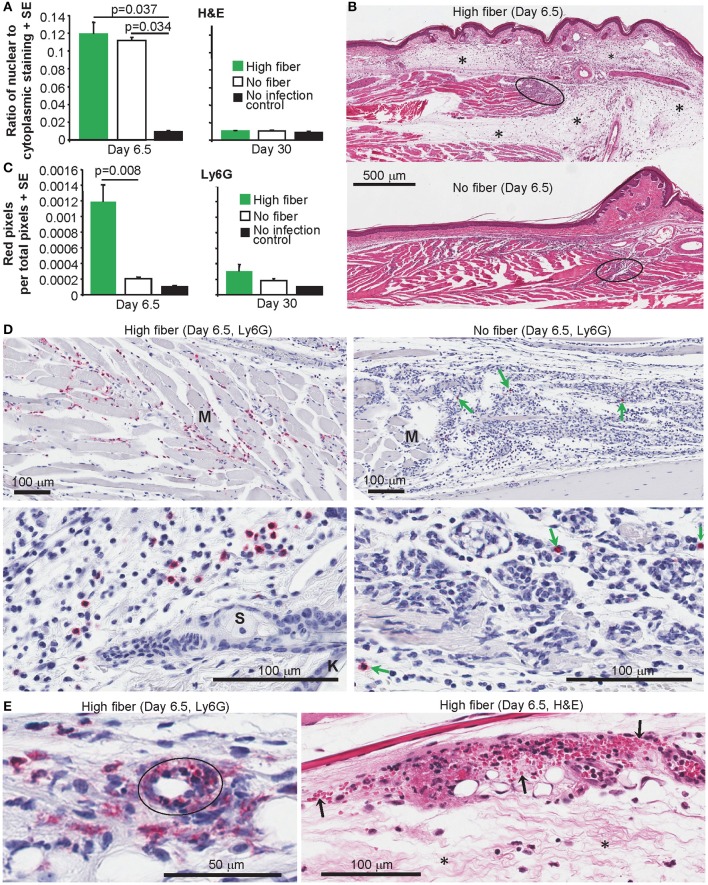
Histology and IHC of feet from CHIKV-infected mice fed high and no fiber diets. (A) Mice were fed with high fiber or no fiber diet and infected with CHIKV or left uninfected (No infection control) (as in Figure 1A). On day 6.5 and day 30 feet from separated groups of mice were examined by histology and H&E staining. Aperio pixel count was used to determine the ratio of strong blue (nuclear) to red (cytoplasmic) staining; a measure of the cellular infiltrate. Statistics by Kolmogorov Smirnov test (p = 0.037, n = 4 feet and mice per group) and Kruskal–Wallis test (p = 0.034, n = 3/4 feet and mice per group). There were no significant differences between any groups on day 30 post infection (n = 4 feet and mice per group). (B) Examples of H&E staining of mice examined in (A). Black ovals indicate areas of high density infiltrates in muscle tissues. Asterisks (*) indicate areas of edema. (C) Feet from groups of mice as in (A) were analyzed by IHC and the neutrophil-specific anti-Ly6G antibody. Anti-Ly6G staining was detected using Warp Red, with red staining quantified by Aperio pixel count. Statistics by Kolmogorov Smirnov test (Day 6.5, p = 0.008, n = 4–9 feet and mice per group). There were no significant differences between any groups on day 30 post infection (n = 5/6 feet and mice per group). (D) Examples of anti-Ly6G IHC (Red) in muscle (top panels) and subcutaneous tissues (bottom panels). M, a muscle bundle; K, keratinocyte epidermal skin layer; S, Sebaceous gland. (E) Anti-Ly6G IHC (Red) showing a blood vessel (black oval) with intramural neutrophils and indications of parietal necrosis. H&E staining showing hemorrhage (extravascular red blood cells indicated by arrows) and edema (*).